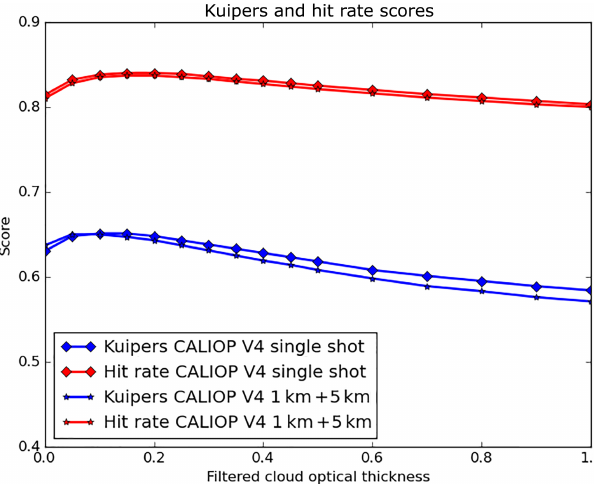
Figure 3. CALIOP-based validation scores (hit rate and Kuipers) as a function of filtered cloud optical thickness (see text for expla- nation) for 80 matched NOAA-18 orbits between October and De- cember 2006. Validation is based on CALIOP version 4.10 CLAY products and show results from two alternative validation methods (single shot or combined 1 and 5km; see text for